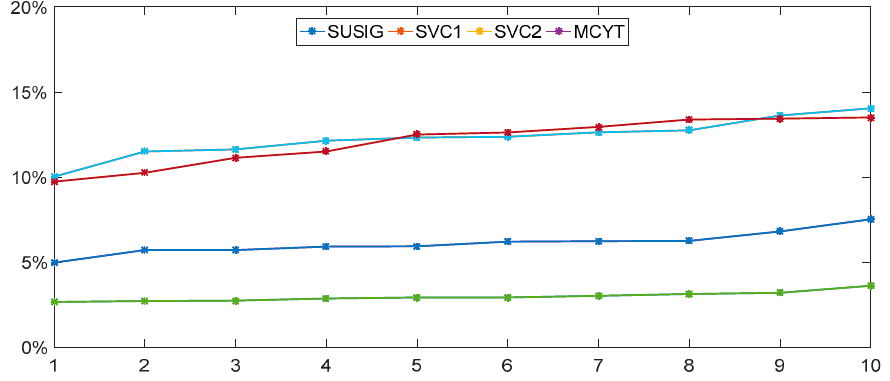
Figure 12. EERs of test results with #1 template repeated 10 times for SUSIG, SVC1, SVC2 and MCYT, respectively.